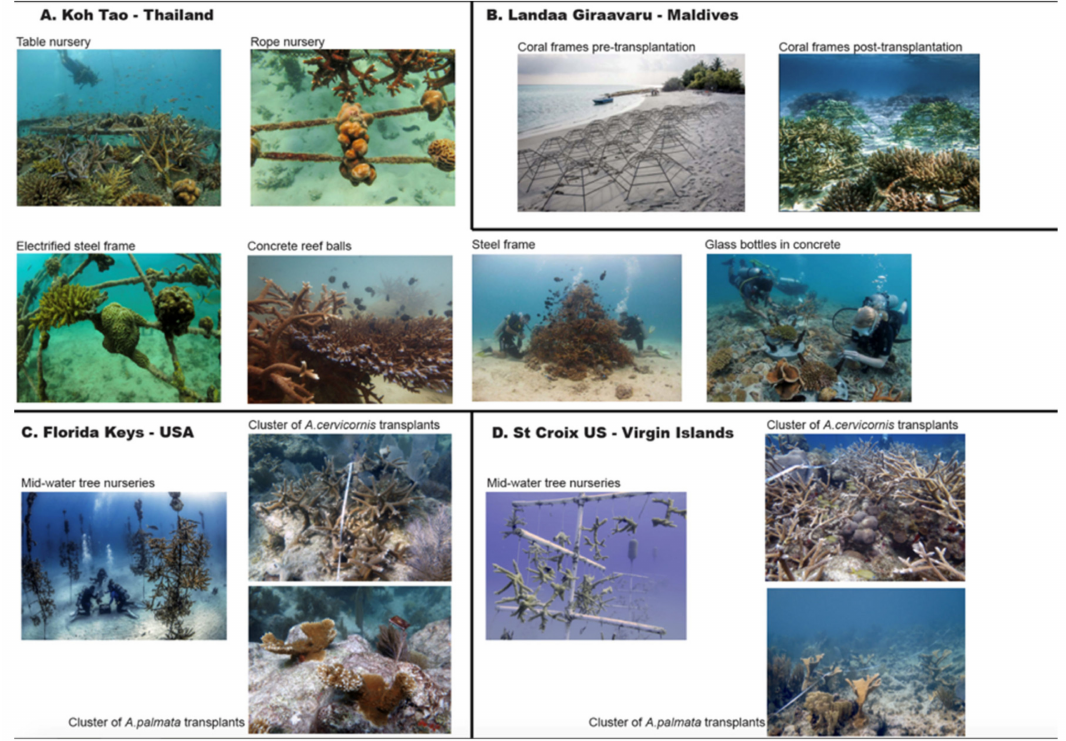
Figure 2. Photo montage illustrating coral restoration strategies at the four coral restoration programs surveyed. Photo credits to Margaux Hein, New Heaven Reef Conservation Program, Reefscapers and Marine Savers, and The Coral Restoration